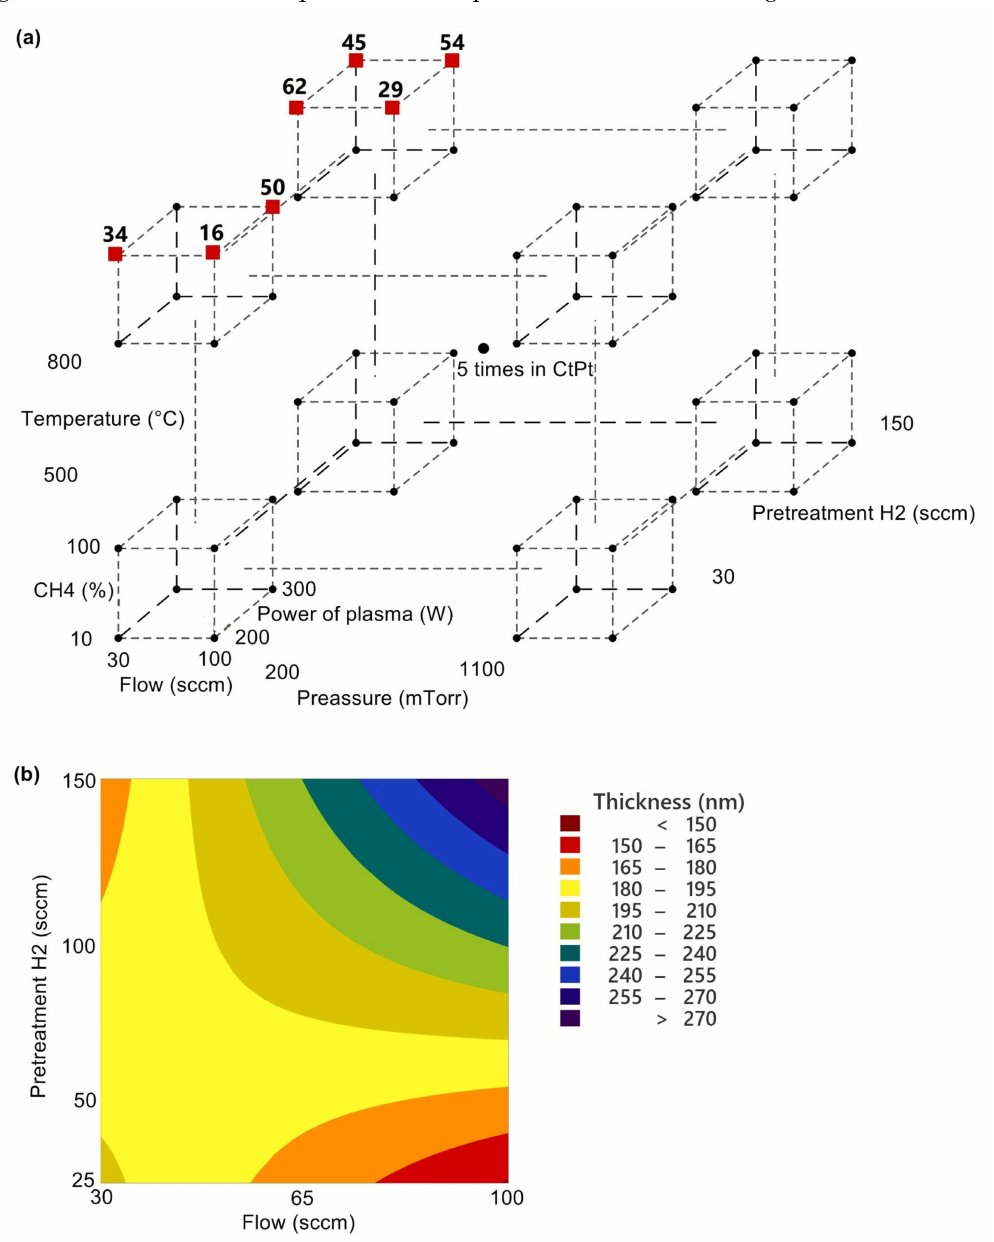
Figure 5. ( a ) Occurrence of vertical graphene with respect to the setting of input parameters, ( b ) Contour Plot of Thicknesses Pretreatment H 2 and